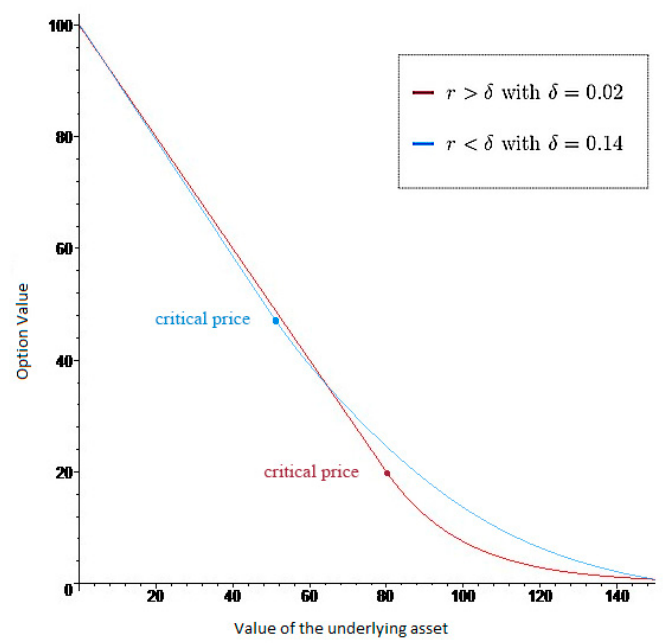
Figure 3. American put option as a function of S . The values of the parameters underlying the construction of this figure are as follows: n , the number of time intervals is 4; τ , the term remaining to maturity is 3 years; r , the interest rate is 0.08; σ , the volatility of the stock price is 0.20; K , the strike price is 100; S 4 , the critical price is 79.66; δ , the rate of dividend distribution is 0.02 and 0.14; and, φ , the value of constant dividends is 0.0.